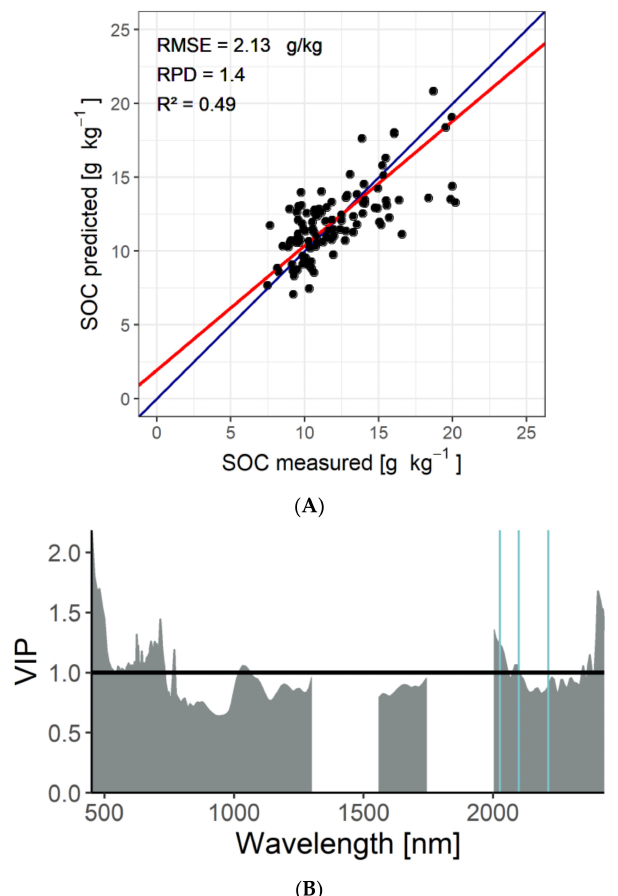
Figure 7. Measured against predicted soil organic carbon content (SOC) in the flight line of the hyperspectral Airborne Prism Experiment (APEX). The blue line is the 1:1 line, the red line is the regression line ( A ) with its variance importance in projection (VIP) scores ( B ). Predictors with VIP values greater than one (area above the horizontal line in the plot) were considered significant for the PLSR model. The blue vertical lines show the wavelengths used for the CAI